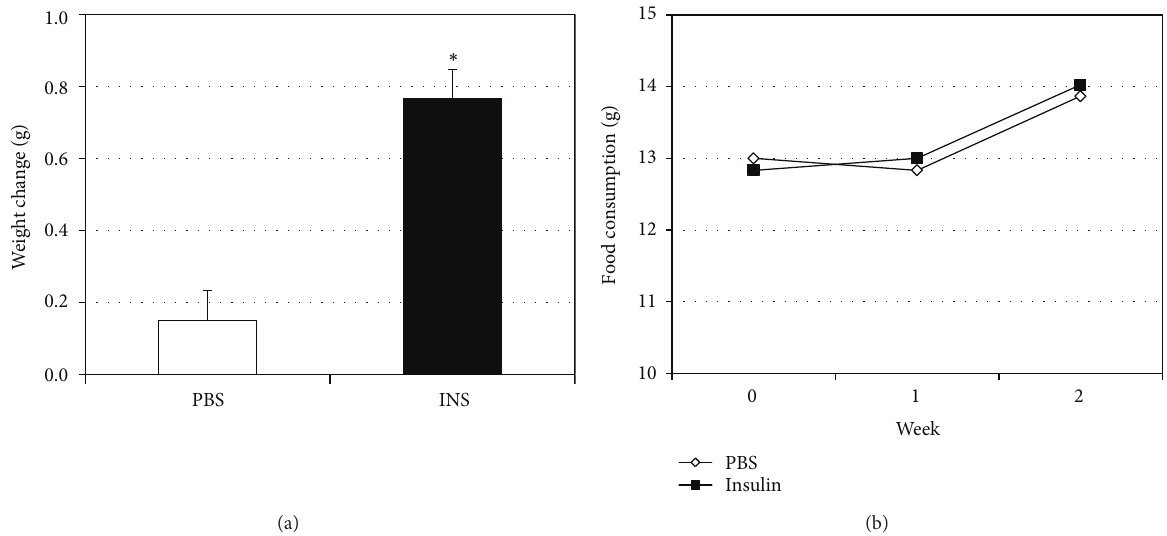
Figure 5: Adult male mice (12weeks) were divided into two groups to receive insulin (INS, 50 nM) or vehicle (PBS) injections every morning for 14d. (a) Body weights were measured before and following treatment period. (b) Weekly food consumption was determined for the week prior to injection (week 0) and for each of the two following weeks of treatment. ∗ 𝑃 < 0.05 , INS versus